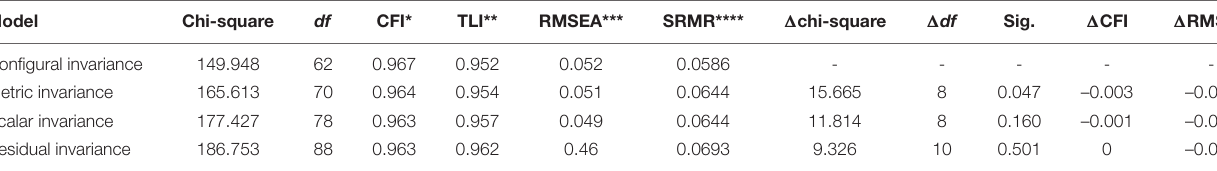
TABLE 5 | Gender invariance analysis of Malaysian version of CFC